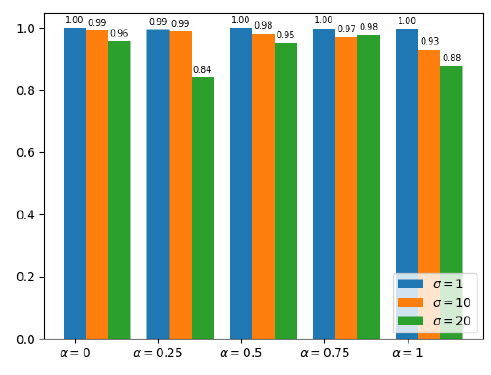
Figure 4. Comparison of fidelity when N = 1000, α is divided into quarters in the interval 0 to